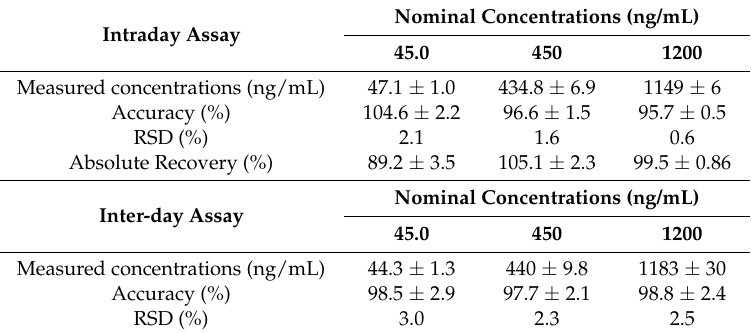
Table 1. Accuracy and precision of the high-performance liquid chromatography (HPLC) assay a